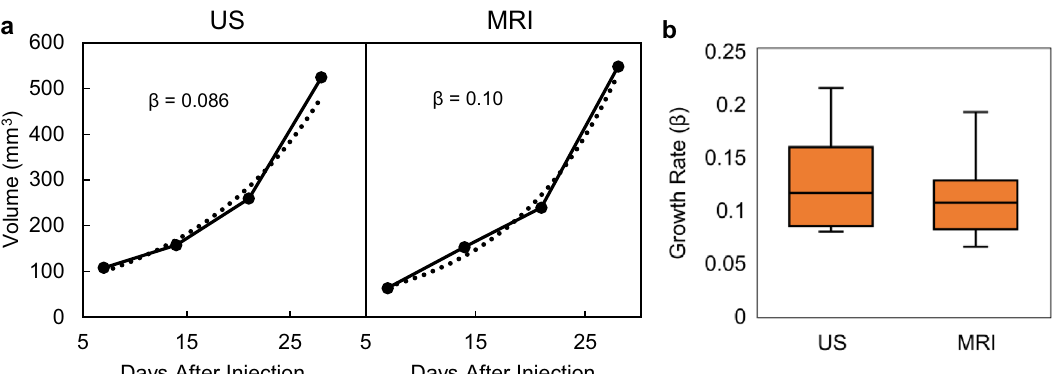
Figure 4. Calculating and comparing tumor volume growth rates. Representative growth curves for the same mouse are shown in ( a ), and box plots of the reported growth rates (β) for all mice as measured by US and MRI in ( b ). The difference in measured growth rates between US and MRI were not significant (p = 0.67).